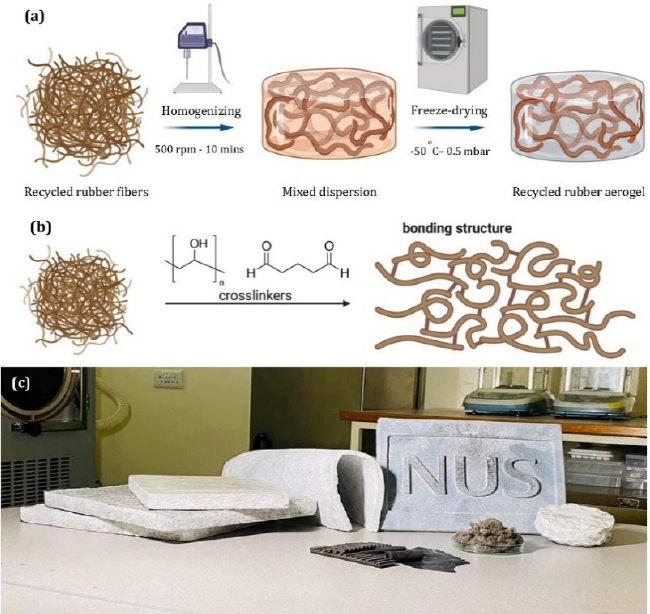
Figure 16. ( a ) Fabrication steps for the recycled rubber aerogels. ( b ) Schematic representation of the bonding structure formation. ( c ) Image presenting typical recycled rubber aerogel samples of different dimensions [114].